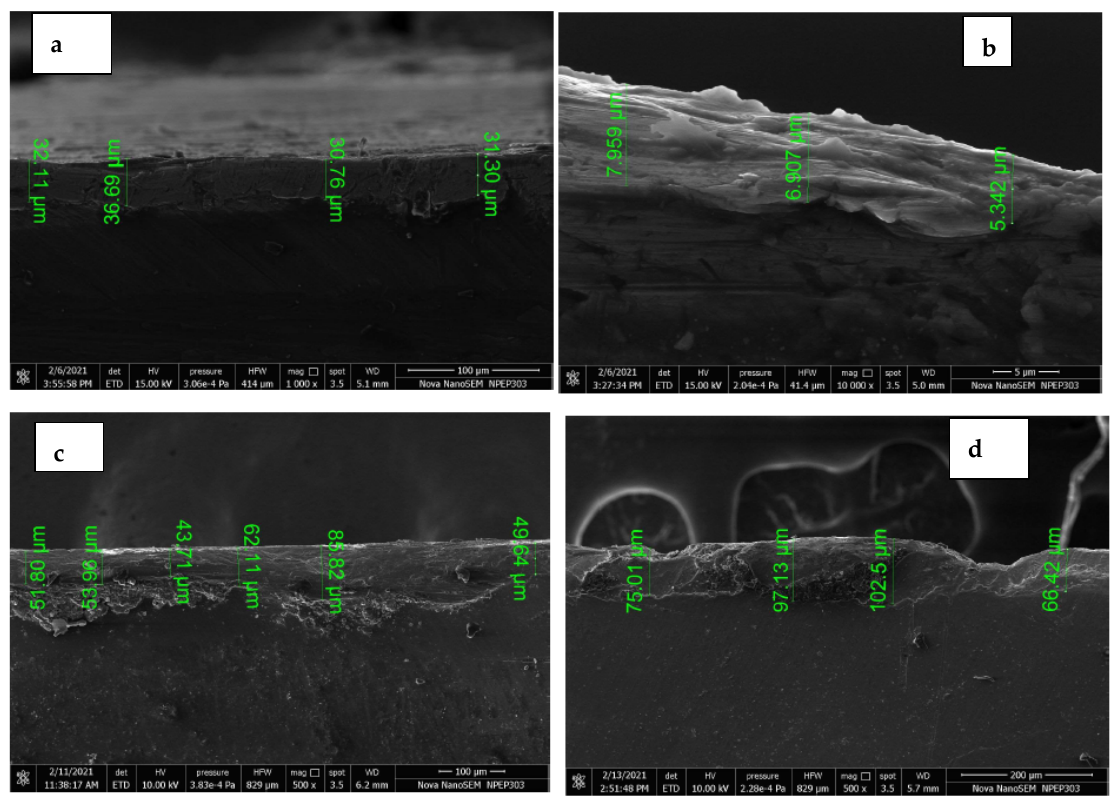
Figure 7. FSEM images for uniformity of the oxide layer at cross-section for an at ( a ) 197 V and 0.3 A. ( b ) At 197 V and 0.3 A. ( c ) At 197 V and 0.5 A. ( d ) At 197 V and 1 A.